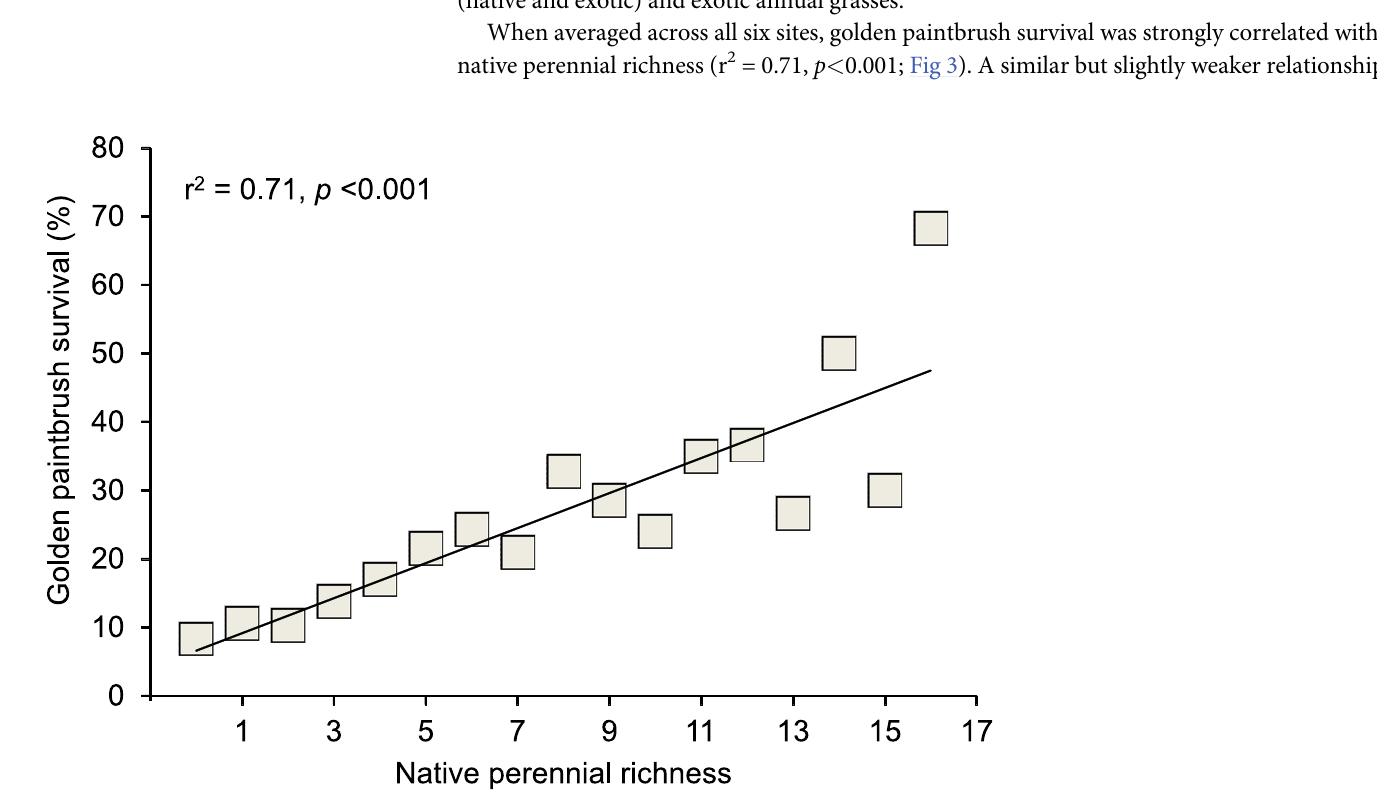
(native and exotic) and exotic annual grasses.